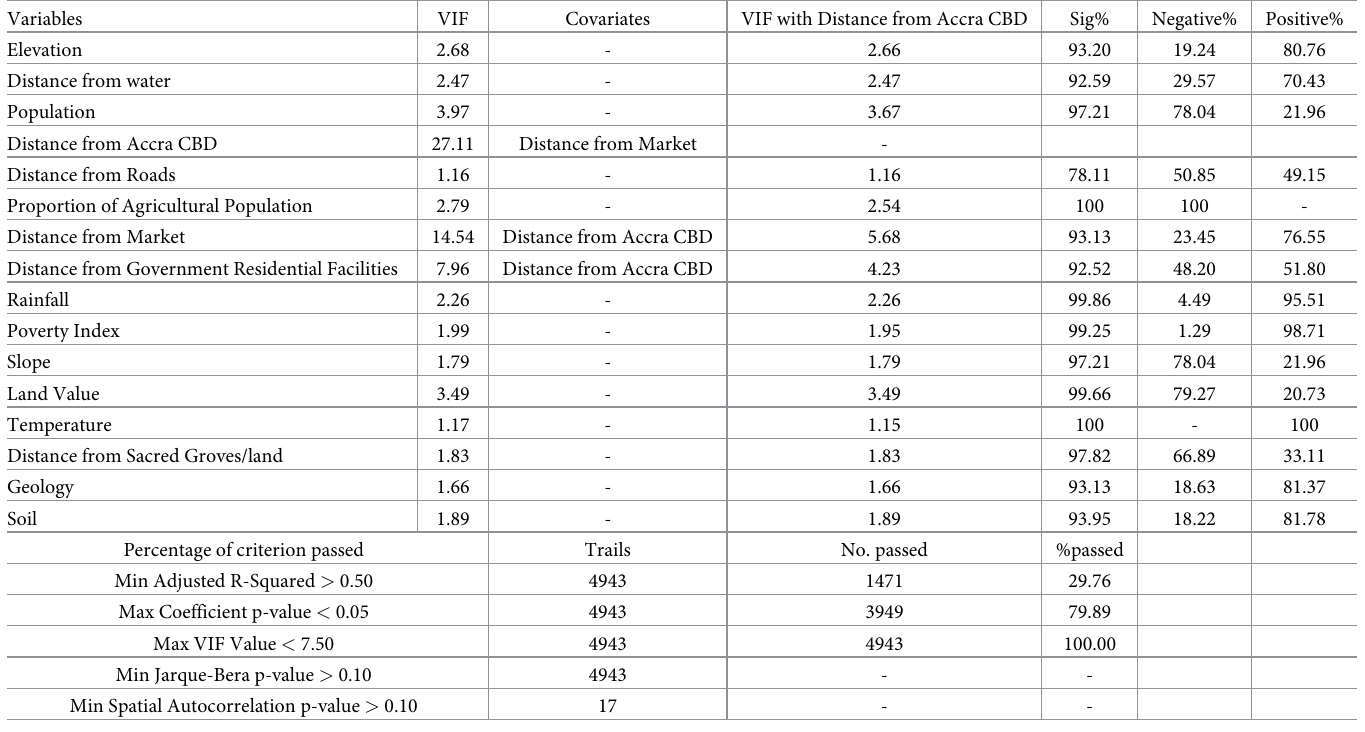
Table 2. Multicollinearity and importance of exploratory